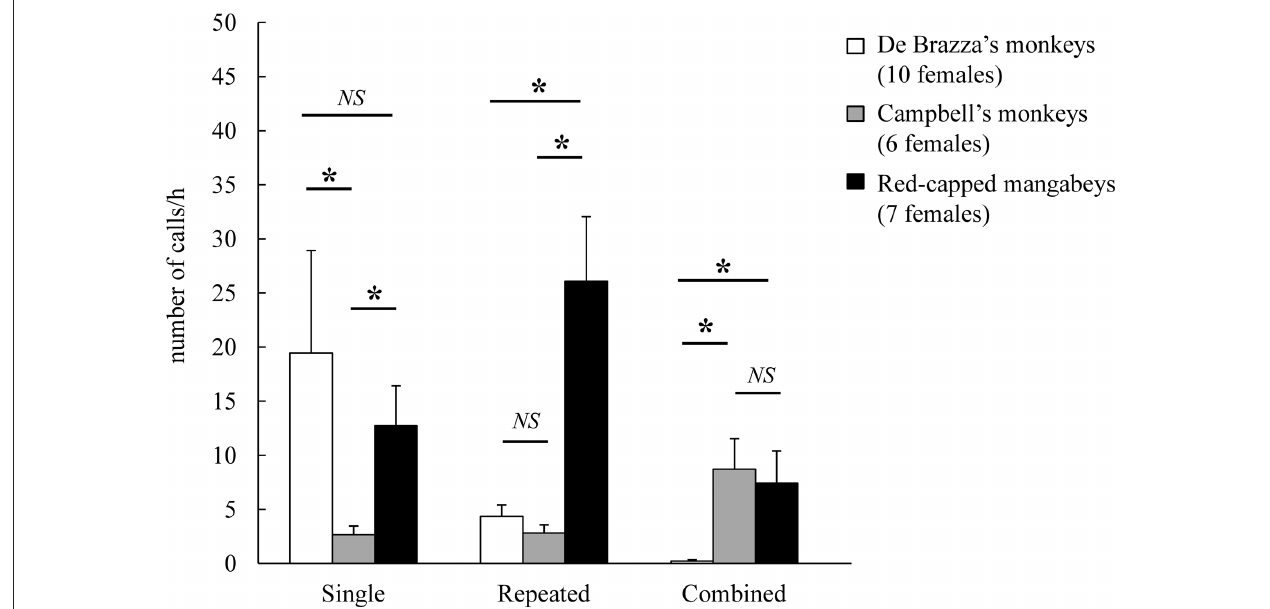
FIGURE 5 | Hourly call rate of “single”, “repeated” and “combined” unit assembling patterns in each of three species of primate. Number of calls/h: X ± SE . Results of the post-hoc multiple comparisons following the Kruskall-Wallis test ( ∗ P < 0 . 05, NS, not significant).